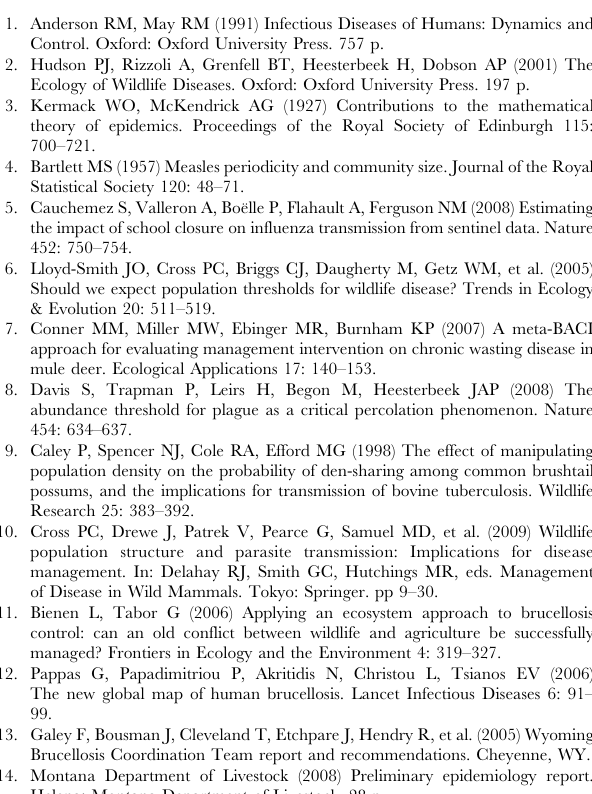
Figure S4 Means of the predictive posterior distributions for Models 1, 2 and 3 (columns from left to right; Table 1) of the 1991 prevalence (row 1), 2009 prevalence (row 2), and the annual time trend (row 3) measured on the logit scale. All seroprevalence estimates were standardized by assuming samples were from management captures. Figure S5 Timeseries of brucellosis seroprevalence in all the hunt areas of northwestern Wyoming that had positive tests. Red squares and lines represent the raw estimates and 95% confidence intervals calculated directly from the empirical data on an annual basis. Black lines represent the mean of the predictive posterior distributions based on Model 1 for each hunt area assuming that all samples were research captures. Areas with supplemental feedgrounds are in the top two rows. Hunt areas 97 and 98 included a test-and-remove effect for